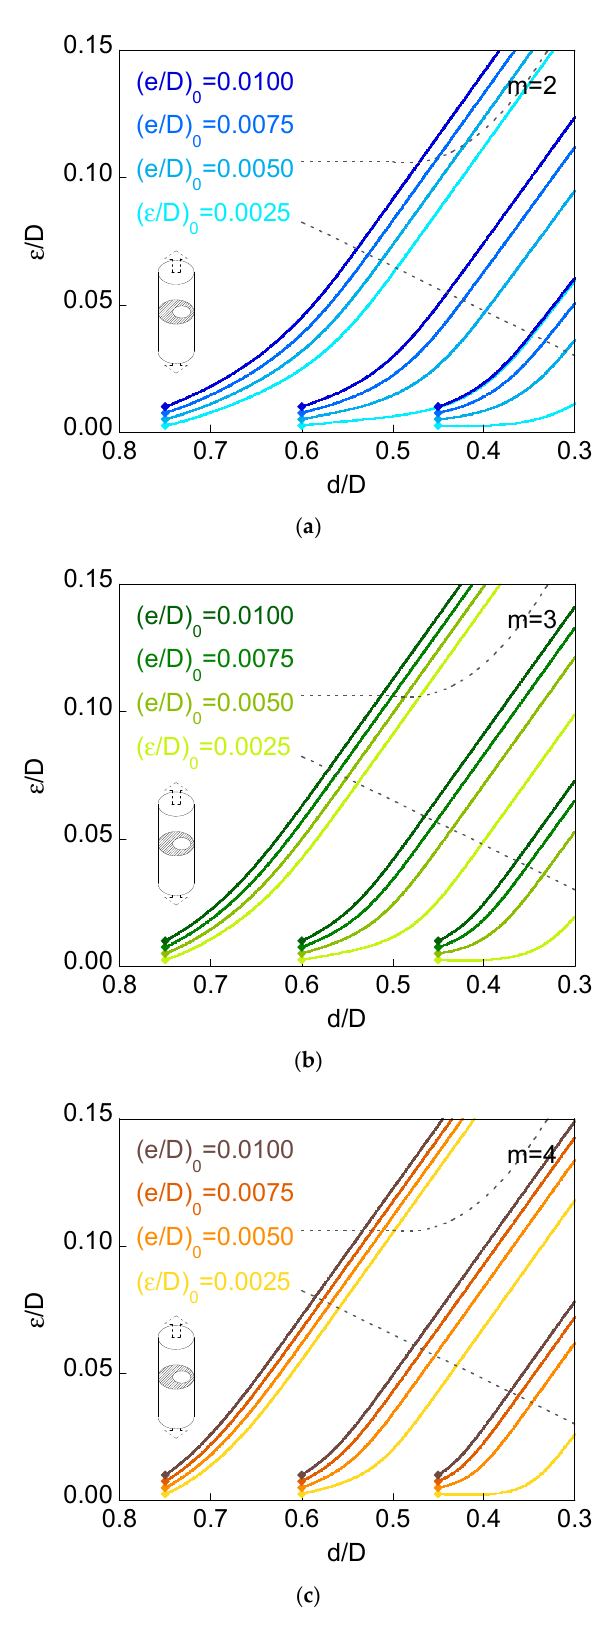
Figure 7. Curves ε / D vs. d / D , fatigue propagation for remote tensile loading : ( a ) m = 2; ( b ) m = 3; ( c ) m = 4.